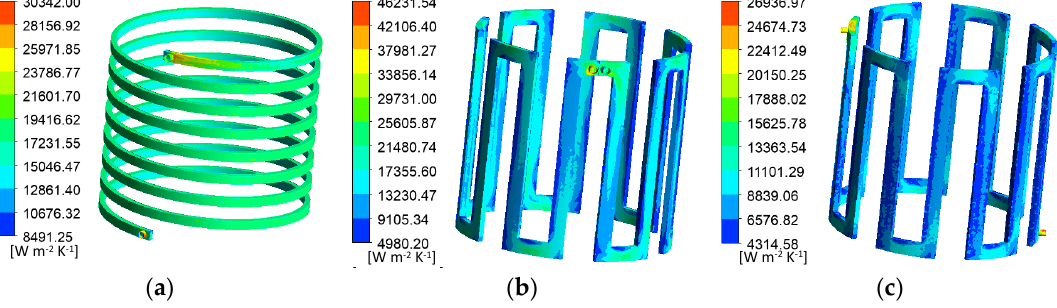
Figure 12. Cooling channel structures. ( a ) Spiral structure; ( b ) axial structure 1; ( c ) axial structure 2.